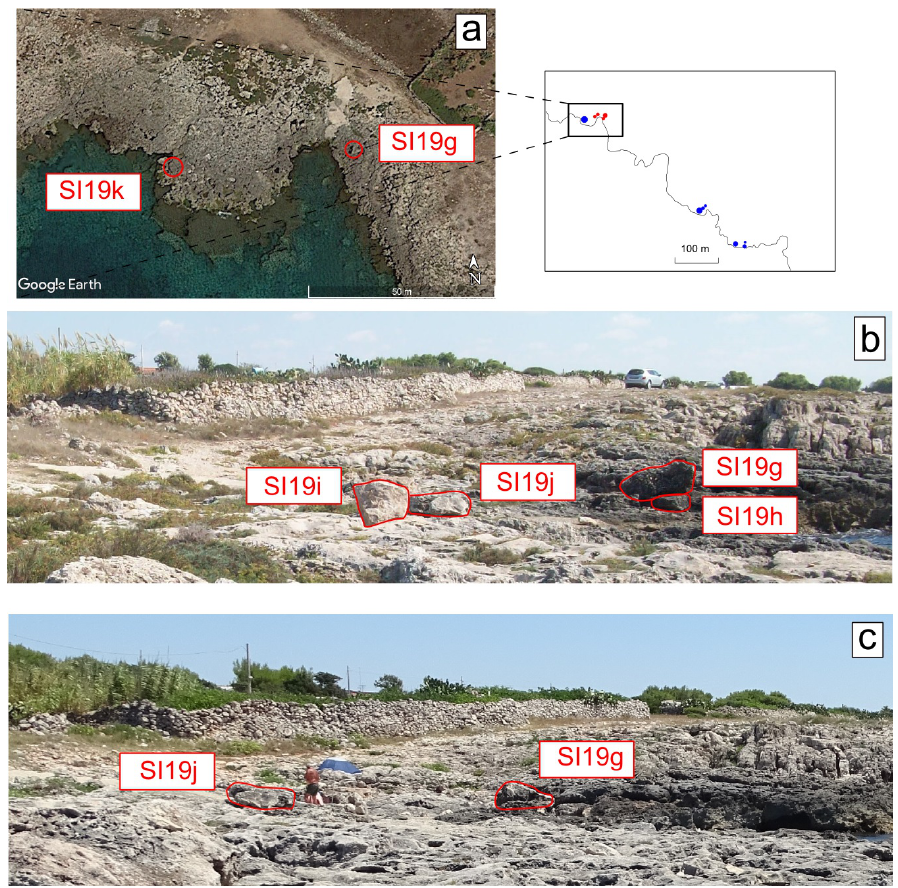
Figure A6. Comparison between pre- and post-storm event states: ( a ) 2015 Google Earth satellite image with the locations of the boulders; ( b ) pre-storm location of Boulders g, h, i, and j; ( c ) post-storm locations; note that Boulders h and i are